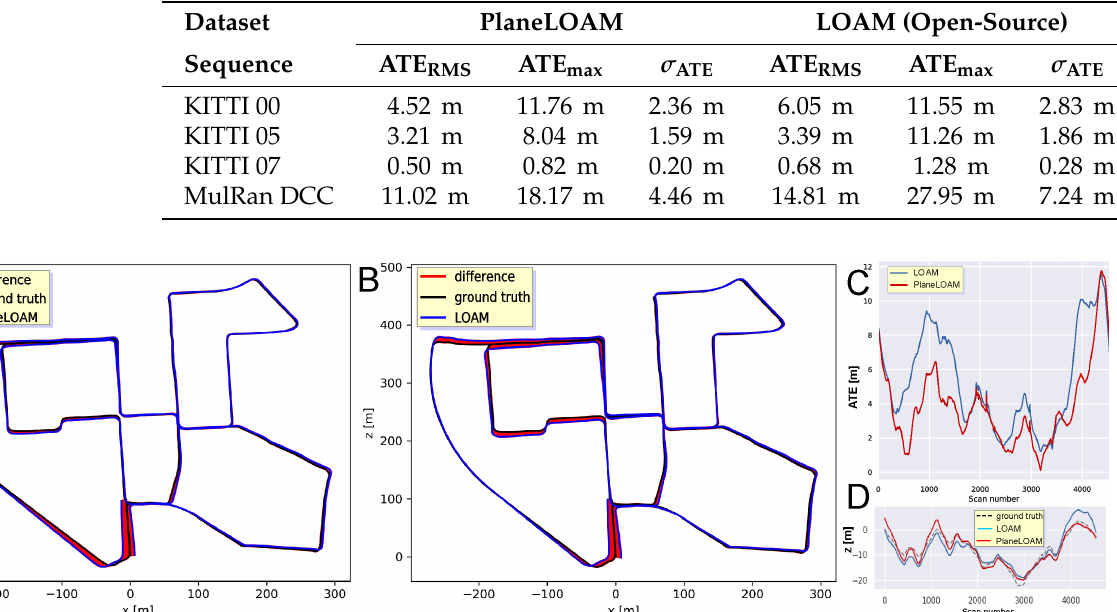
Figure 14. Absolute trajectory errors for the KITTI 00 sequence acquired with a Velodyne HDL-64E LiDAR. The PlaneLOAM trajectory ( A ) has smaller deviations from the ground truth than its counterpart estimated with the open-source LOAM ( B ). This is visible in the plot showing ATE errors vs. consecutive scan numbers ( C ). Smaller errors in the elevation ( z axis) contribute to the overall better performance of PlaneLOAM ( D ).